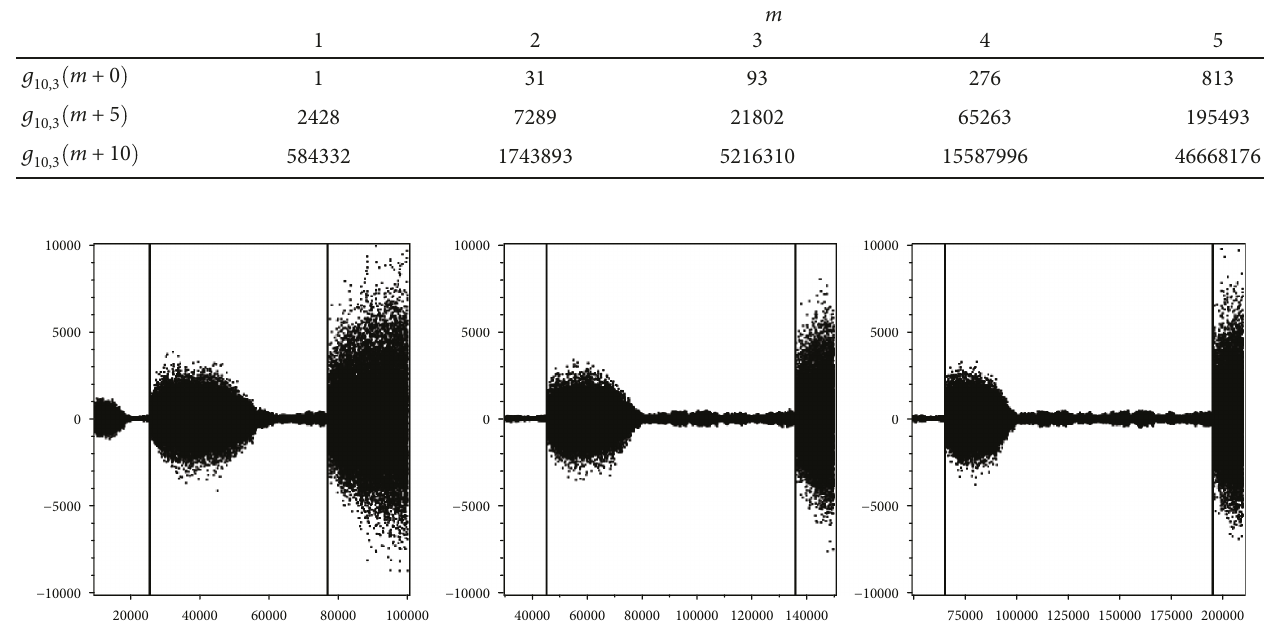
Figure 8: Illustrations of g